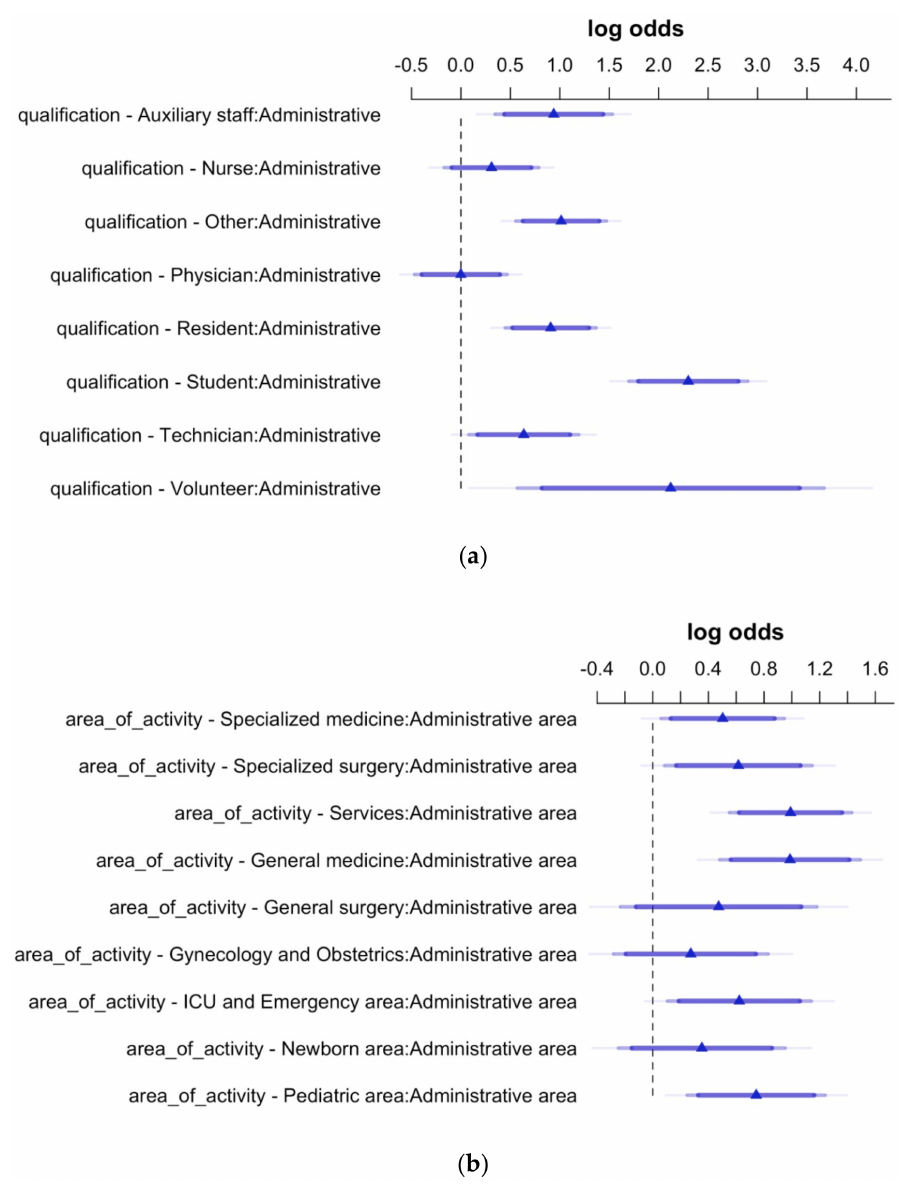
Figure 3. HCWs’ propensity towards being newly vaccinated against influenza-log of the odds and their 95% CIs extracted from two models having HCWs’ qualification ( a ) and area of activity ( b ) as predictor variables. Statistical significance for the effects is shown when the 95% Confidence Intervals do not cross the vertical dashed line set to